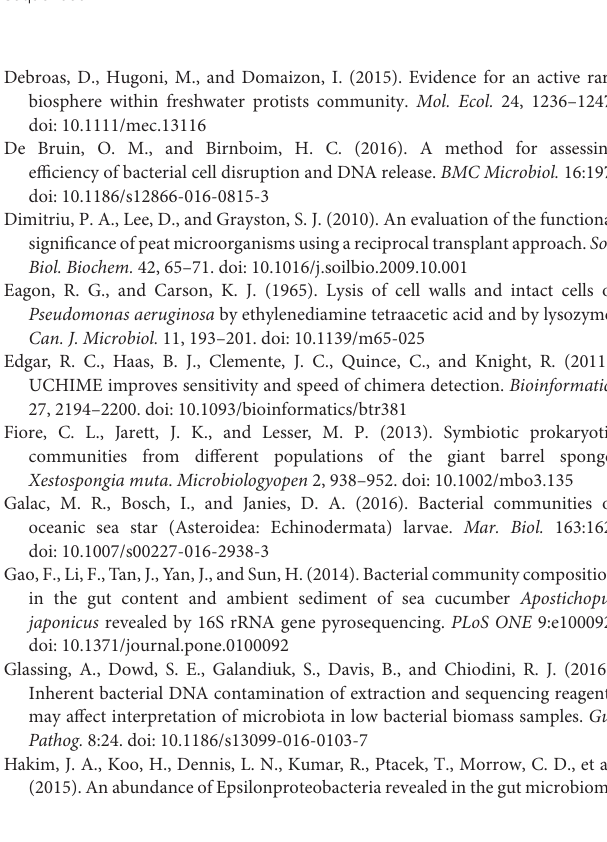
Supplemental Figure 1 | Bar chart showing growth in number of publications from 1992 to 2017 in the four invertebrates; coral (in blue), sponge (in orange), mollusc ∗ (in gray), and echino ∗ (in yellow).